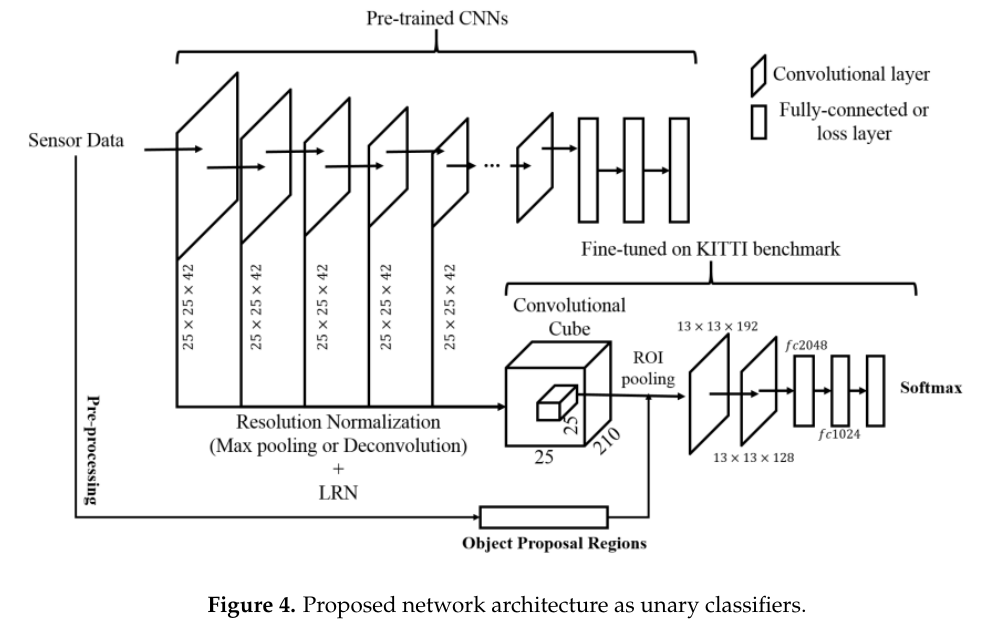
Figure 4. Proposed network architecture as unary